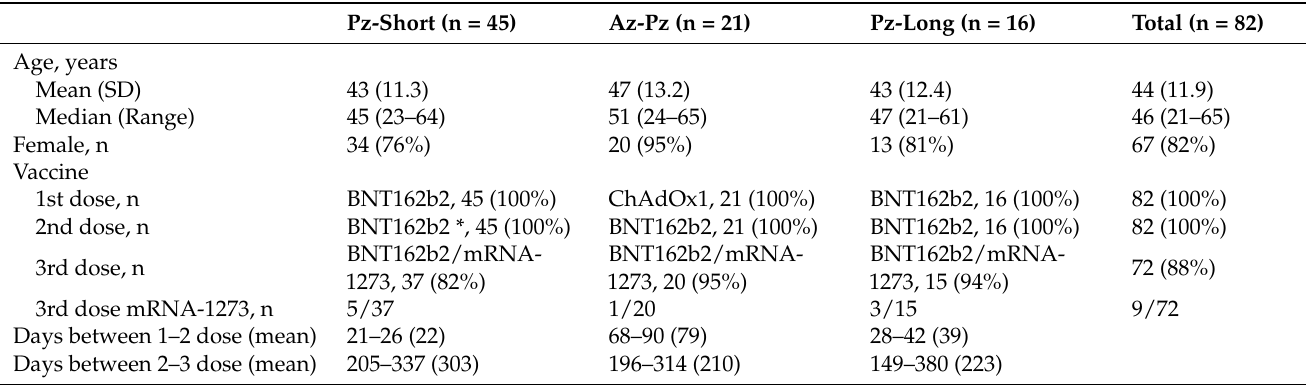
Table 1. Description of